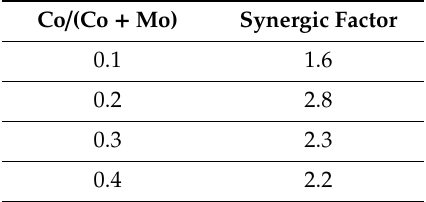
Table 2. Synergic effect in the HDO of phenol with CoMo/AT2 at different Co concentrations. Table 2. Synergic e ff ect in the HDO of phenol with CoMo / AT2 at di ff erent Co concentrations.